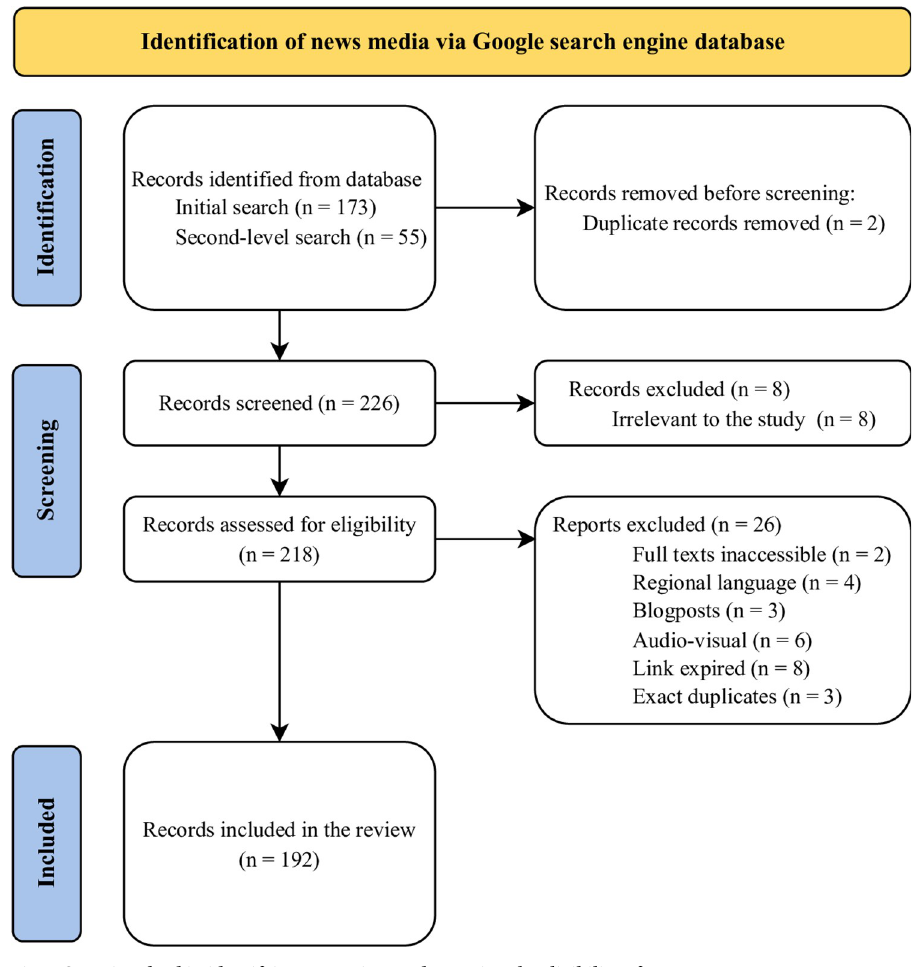
Fig 1. Steps involved in identifying, screening, and assessing the eligibility of news